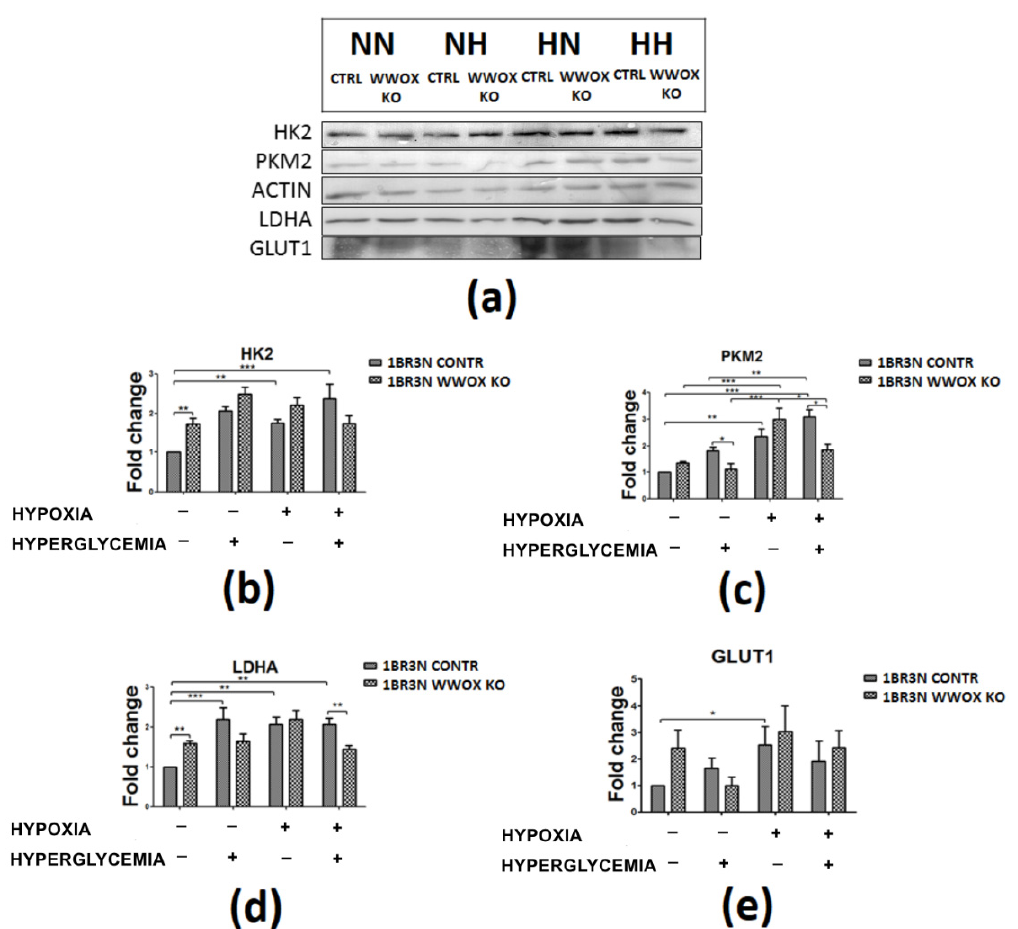
Figure 7 . The western blot analysis of selected proteins (HK2, PKM2, LDHA, GLUT1) of CONTR and WWOX KO 1BR.3.N cells after 48h incubation in four tested condition ( a ). Bar graphs showing the relative level OD density of HK2 ( b ), PKM2 ( c ), LDHA ( d ), GLUT1 ( e ) to ACTIN. Results of ANOVA with a post-hoc Tukey-Test are shown as mean ± SEM. *, p < 0.05; **, p < 0.01; ***, p < 0.001. NN—normoxia normoglycemia, NH—normoxia hyperglycemia, HN—hypoxia normoglycemia, HH—hypoxia hyperglycemia.